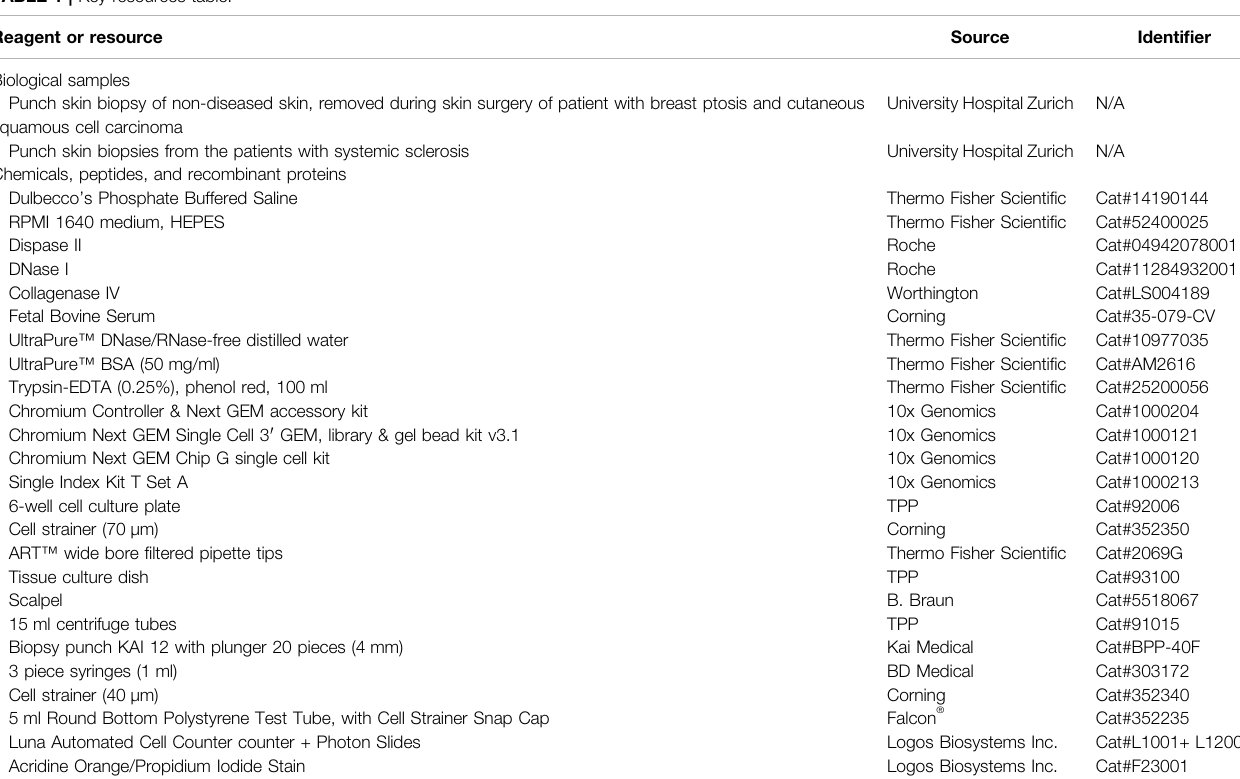
University Hospital Zurich N/A